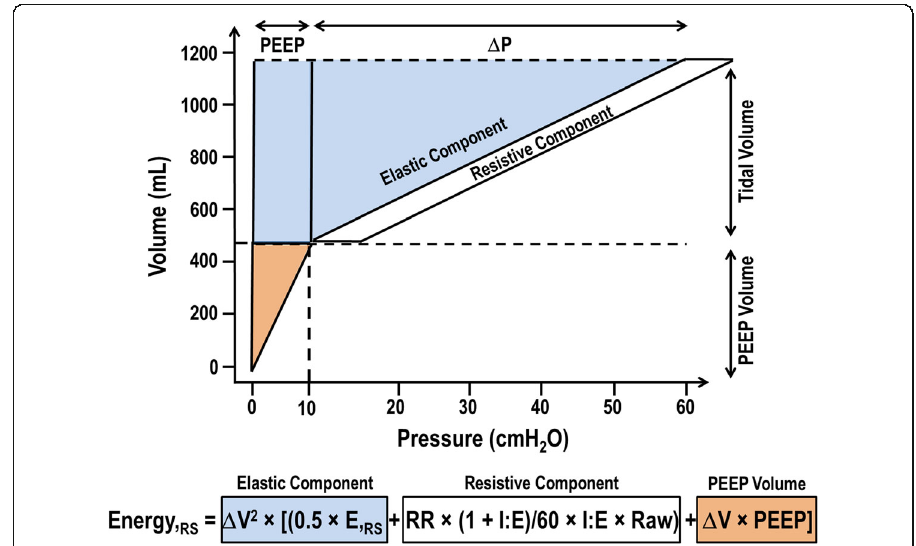
Fig. 2 Mechanical power calculation, which includes the resistive properties and variation of lung volume correspondent to PEEP level. All components are depicted below the schematic figure: elastic, resistive,